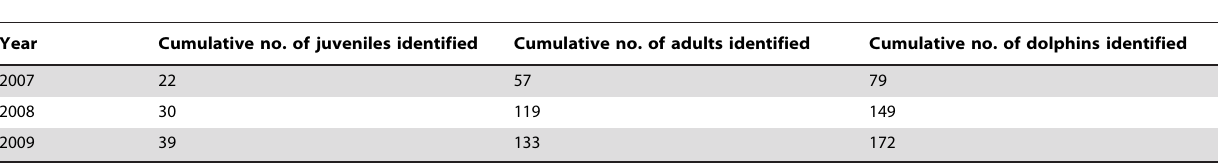
Table 4. Cumulative number of individually identified bottlenose dolphins during the study period (March 2007 and November